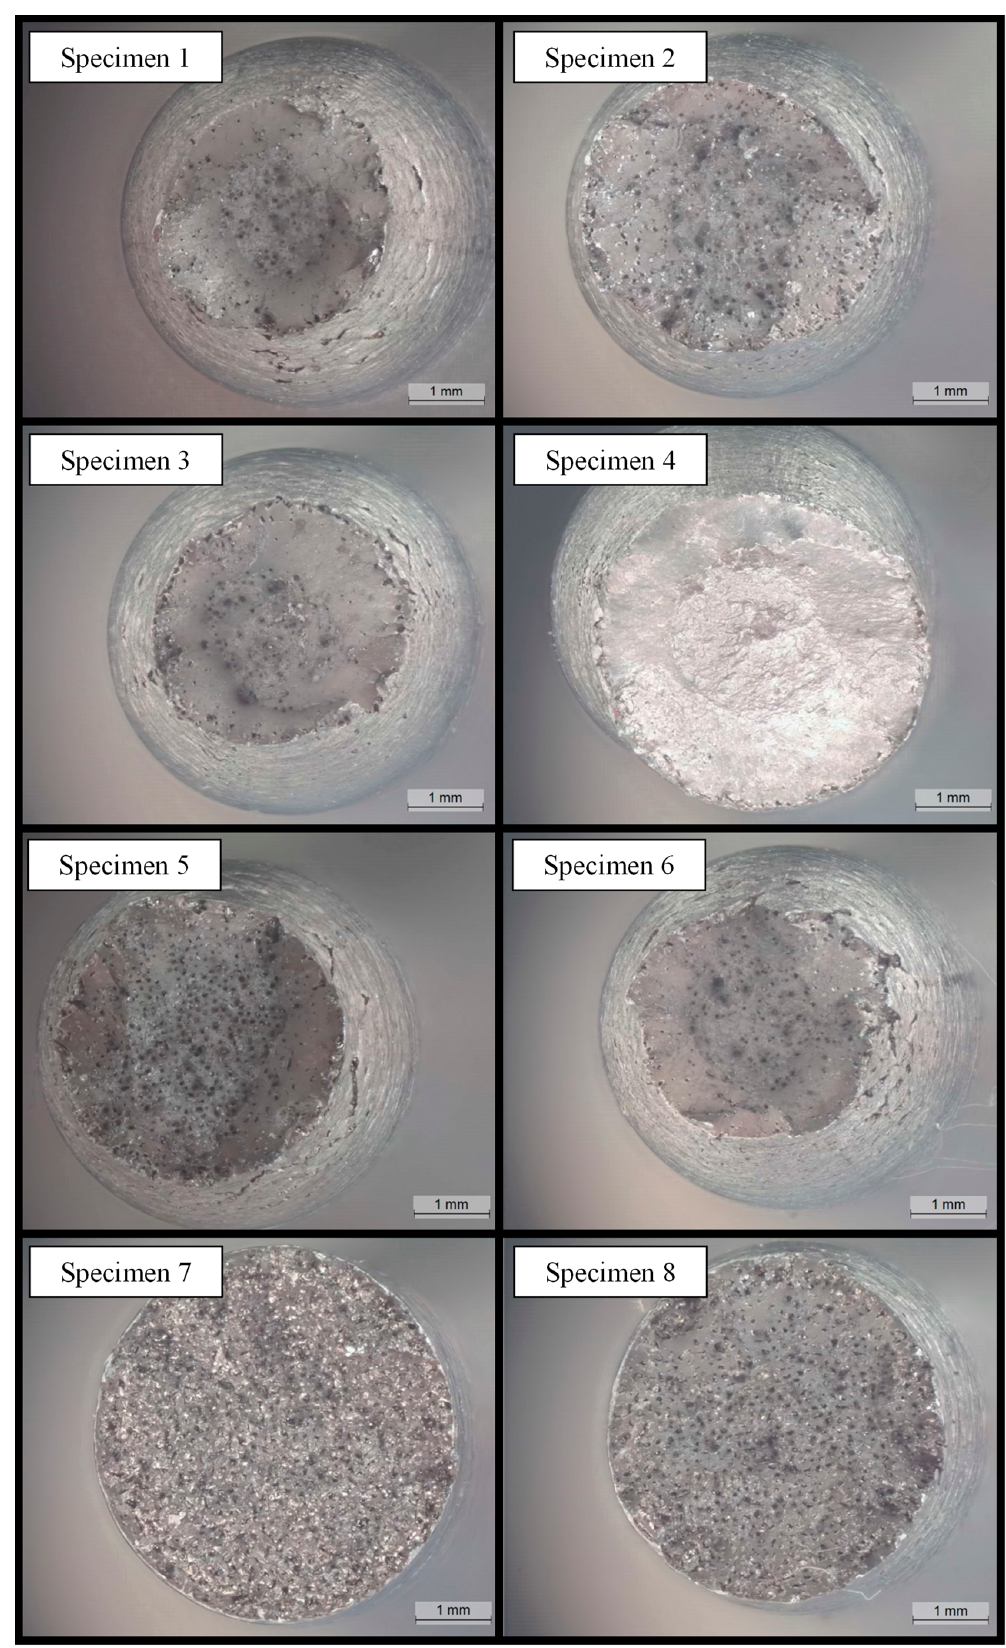
Figure 3. Optical micrographs of specimens 1 to 8.